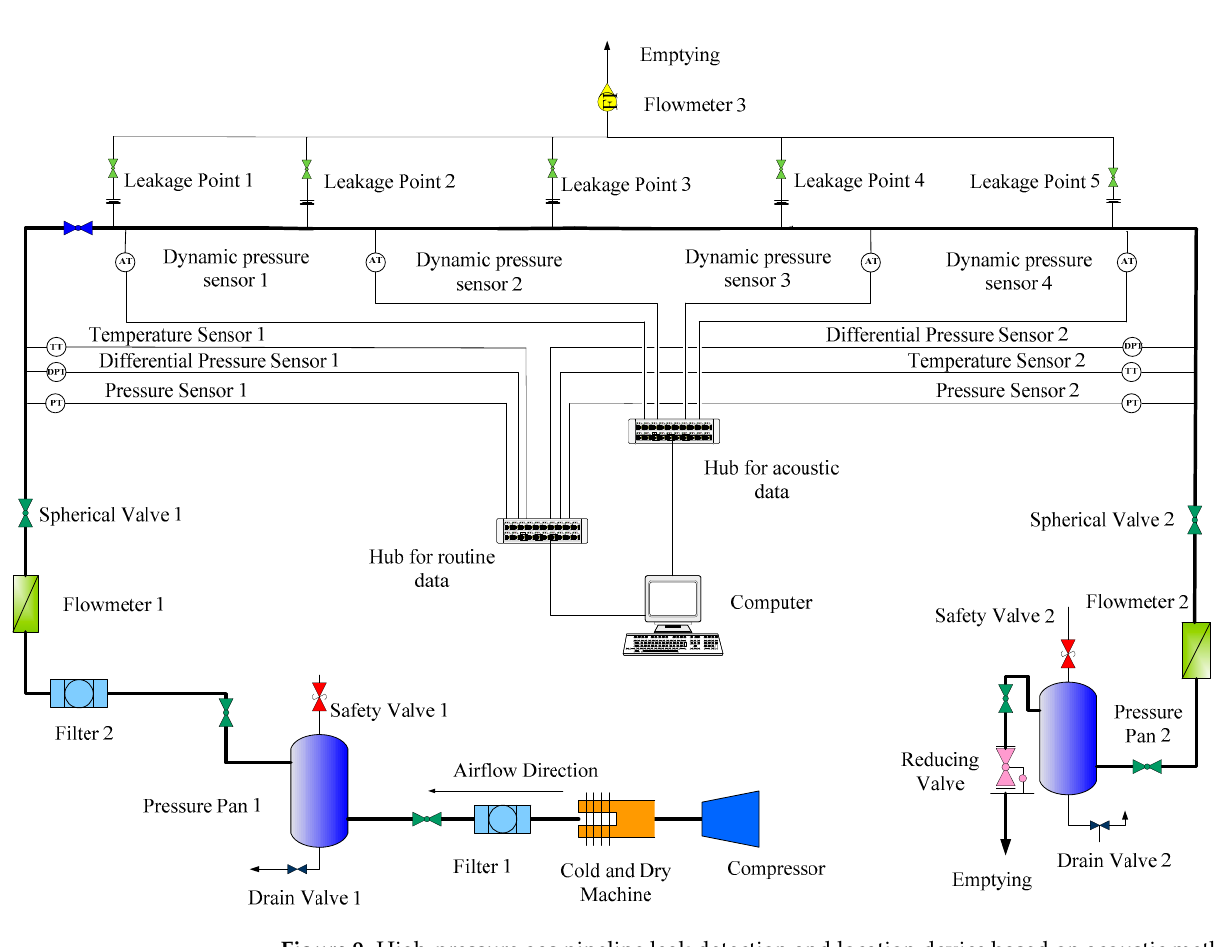
Figure 9. High-pressure gas pipeline leak detection and location device based on acoustic method.